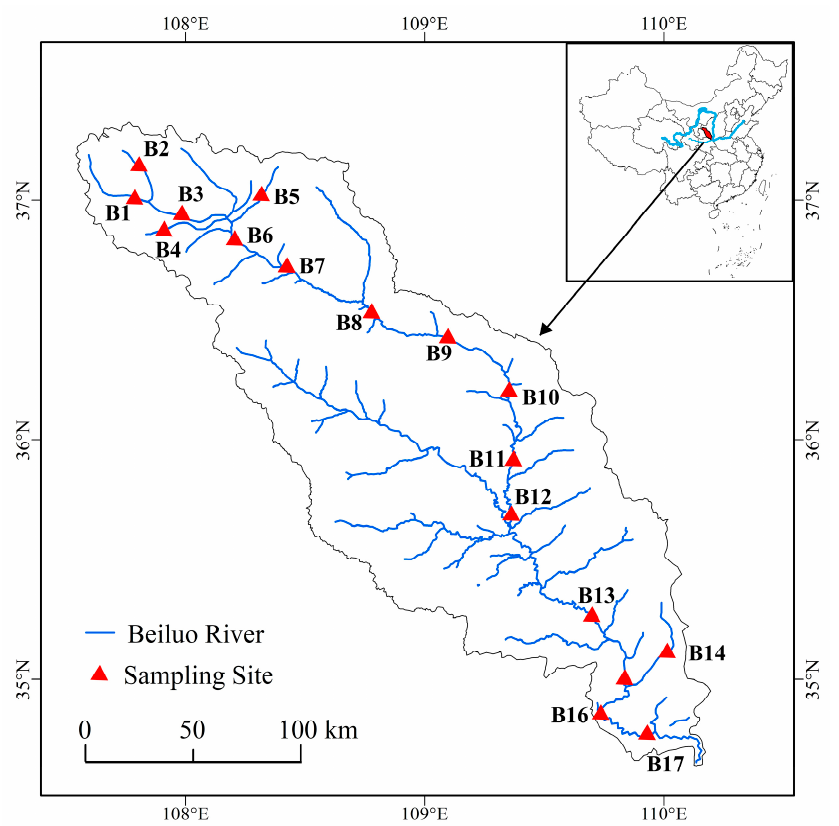
Figure 1. Study area with sampling sites marked with red triangles. Beiluo River Basin is located in Loess Plateau in northern Shaanxi Province, the middle of China.